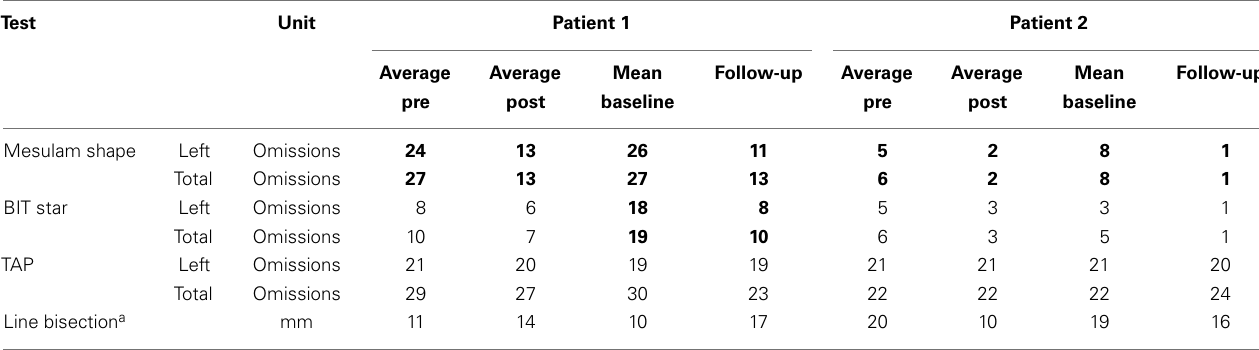
Table 2 | Summary of results .